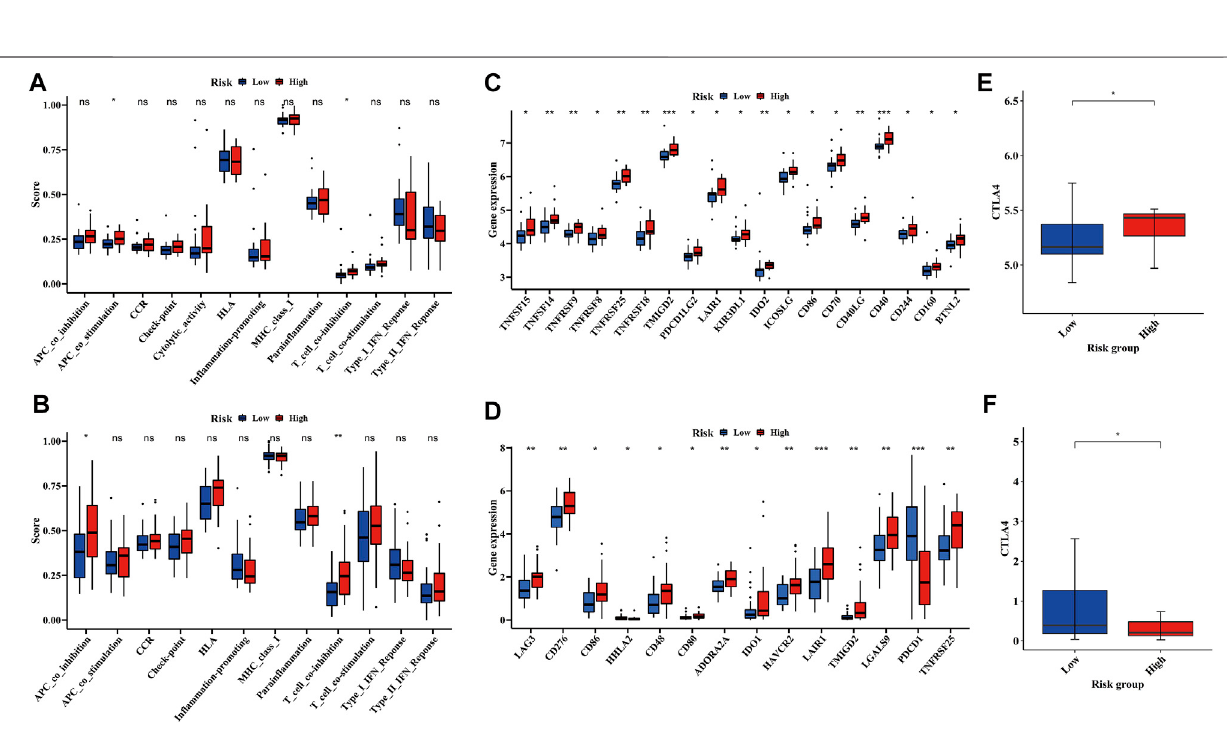
FIGURE 6 | Difference of immune-related pathways and immune checkpoints between low- and high-risk groups in both GEO and ICGC cohort. (A,C,E) Comparison of immune-related pathways and immune checkpoints between two risk groups in the GEO cohort. (B,D,F) Comparison of immune-related pathways and immune checkpoints between two risk groups in the ICGC